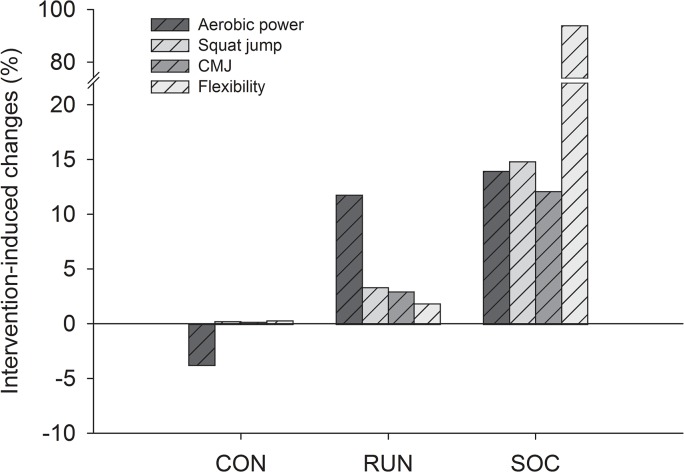
Intervention-induced changes in health related fitness parameters for soccer (SOC), running (RUN) and control (CON) group.